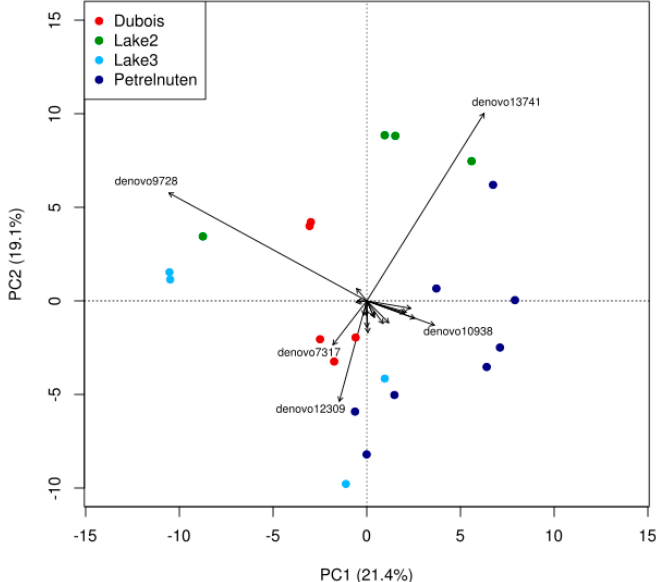
Figure 6. Principal component analysis of eukaryotic OTUs revealing compositional differences between sampling locations. The lowest possible level of taxonomic identification varied strongly between OTUs. Full details of the OTU identities can be found in Table S7.